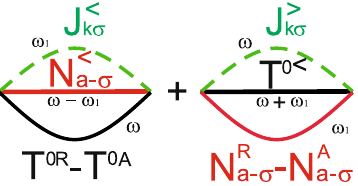
Figure 3. Leading diagrams contributing to the zero frequency noise in the T